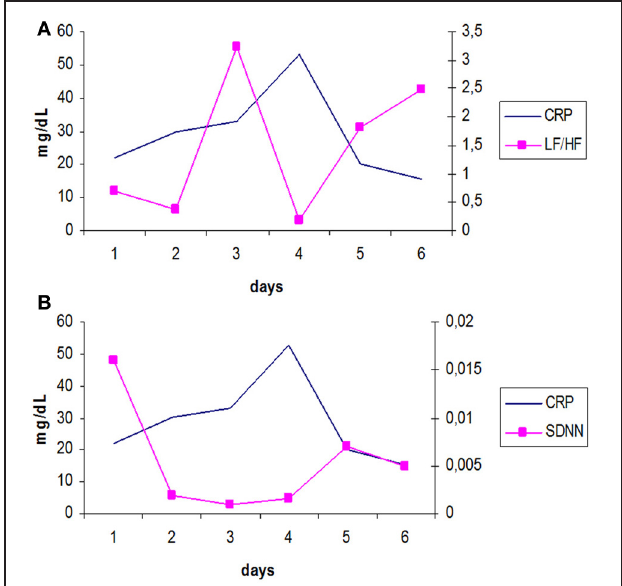
FIGURE 1 | (A) Longitudinal trends over time of mean values of CRP and LF/HF ratio, reflecting sympathovagal balance, for patients with SOFA > 10, during the 6 days of study period. [log transformed data, adapted from Papaioannou et al. (2009)]. It appears that LF/HF changes inversely with CRP. (B) Longitudinal trends over time of mean values of CRP and SDNN (secs), for patients with SOFA > 10, during the 6 days of study period. [log transformed data, adapted from Papaioannou et al. (2009)]. There is a progressive increase in SOFA score from day 1 until day 4 (development of septic shock) and a subsequent downward shift in its values. At the same time, the variability of heart rate signals estimated with SDNN seems to be significantly reduced during the development of septic